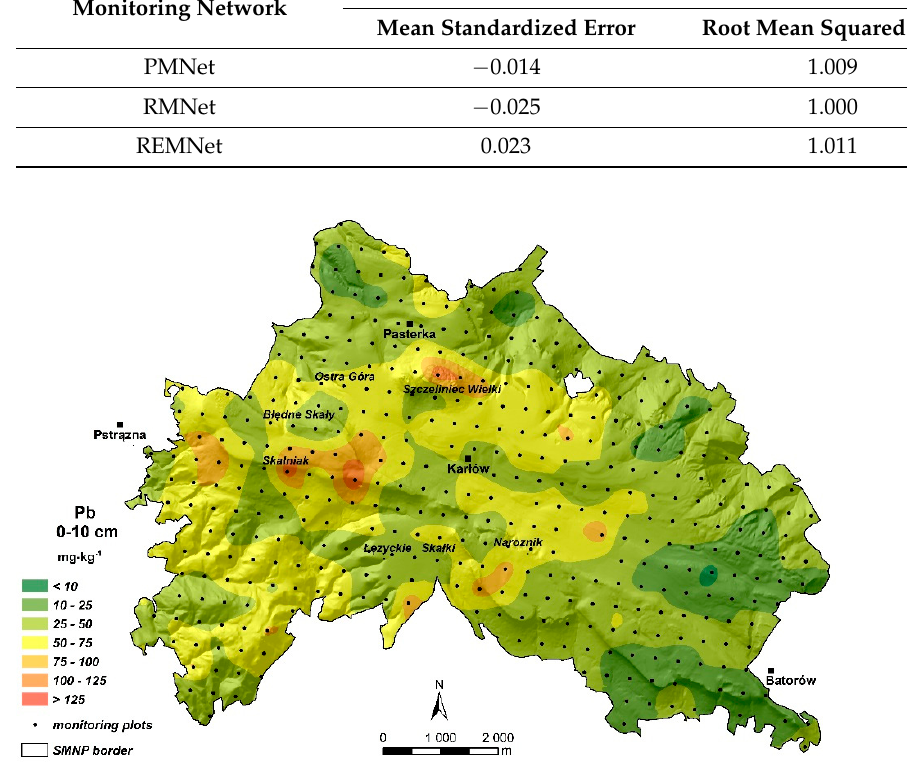
Figure 3. Prediction map of the spatial Pb distribution, developed by simple kriging for the pri- mary monitoring network